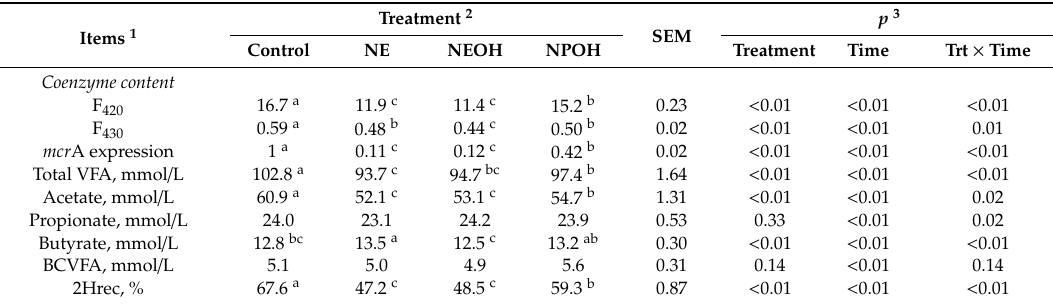
Figure 2. Effect of NE, NEOH, and NPOH addition to culture fluids on CH 4 ( a ), H 2 ( b ), and CO 2 ( c ) production of grain-rich feed incubated with rumen fluids obtained from lactating dairy cows. NE: nitroethane; NEOH: 2-nitroalcohol; NPOH: 2-nitro-1-propanol. Statistical analyses showed the effects of nitrocompounds on CH 4 , H 2 , and CO 2 , with correlations significant at p < 0.01. Table 2. E ff ect of NE, NEOH, and NPOH addition (10 mmol / L) on coenzyme content, mcr A gene expression, and volatile fatty acid (VFA) production in fermentation fluids across di ff erent incubation times (6, 12, 24, 48, and 72